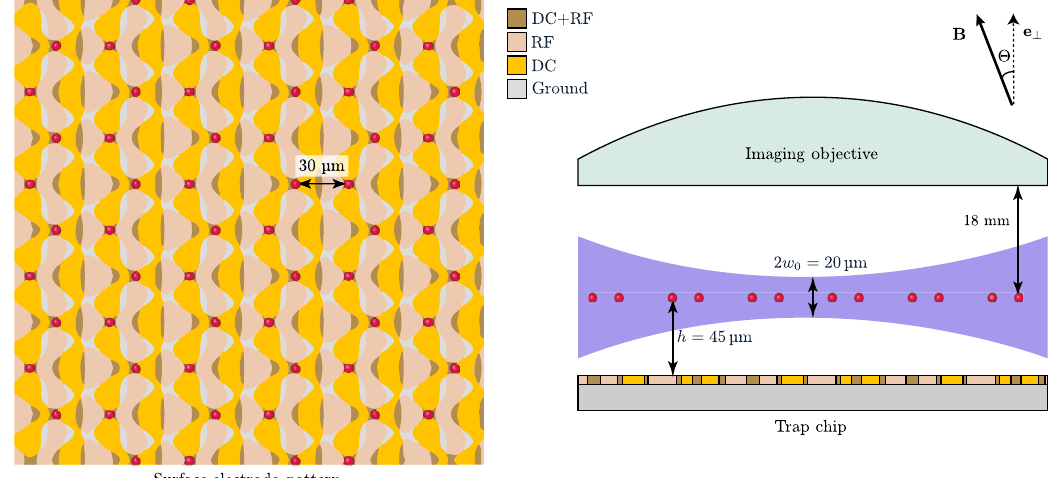
FIG. 10. Top and side view of an example trap architecture for a honeycomb array of 62 beryllium ions, with a nearest-neighbor distance d ¼ 30 μ m. Ions are trapped at a distance of h ¼ 45 μ m above the surface of the electrodes and are globally addressed, cooled, and detected by lasers parallel to the surface. The electrodes labeled dc generate the static electric potential, which, in conjunction with the global magnetic field, provides three-dimensional confinement at the sites marked in red. Tilting the magnetic field and the confining axis of the electric potential with respect to the normal of the electrode plane allows for laser cooling of all modes of motion with lasers parallel to the surface. The electrodes labeled rf provide the weak oscillating axialization field for laser cooling the radial modes of motion. Imaging is carried out with an objective placed at a working distance of 18 mm from the